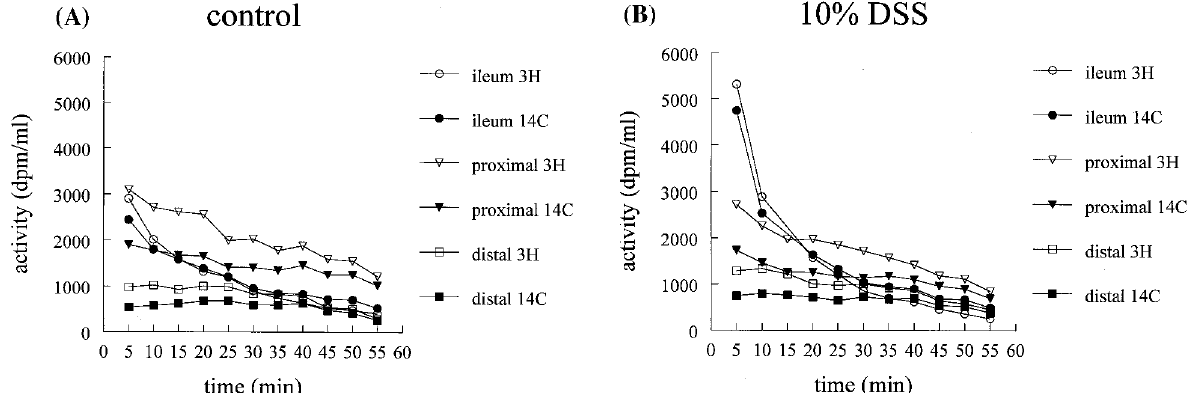
FIG. 2. Permeability monitored with 3 H-mannitol (3H) and 14 C-PEG 400 (14C) from luminal towards serosal side in different intestinal segments of a control (A) and 10% DSS-treated mouse